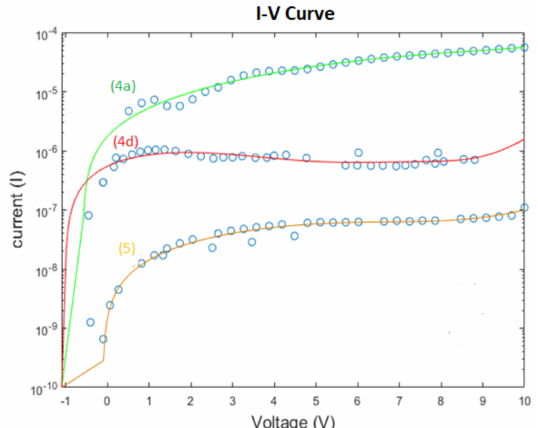
Figure 4. Comparison between electrical characteristics of 4a , 4d , and 5 phenolic polymers.